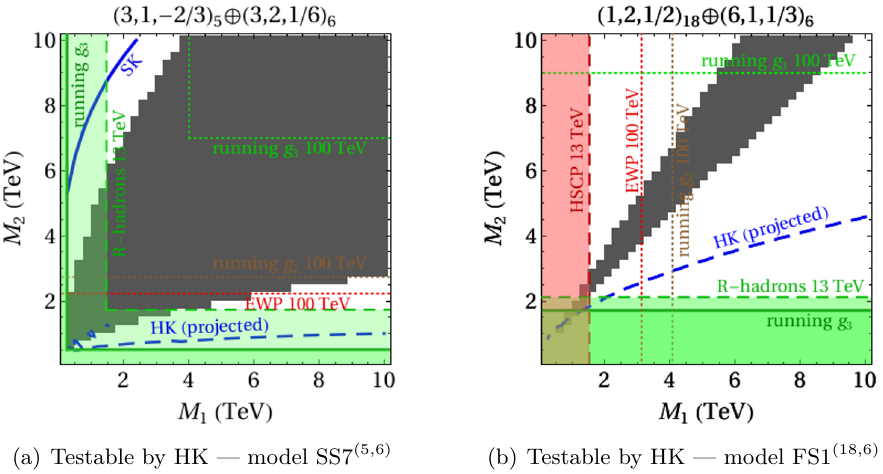
Figure 4 . Summary of experimental bounds on masses M 1 and M 2 for scenarios (a) SS7 (5 , 6) and (b) FS1 (18 , 6) . The color code is the same as in figure 2. Blue solid line marks the exclusion by the proton decay measurement at Super-Kamiokande [35]. Blue dashed lines indicate the projected reach of Hyper-Kamiokande